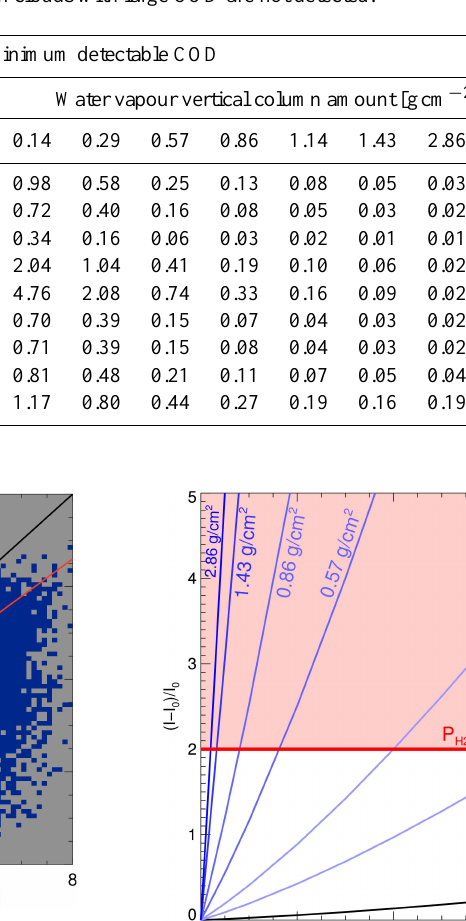
Fig. 3. Comparison of seven years (2003–2009) of SCIAMACHY WFM-DOAS and ECMWF water vapour vertical column amount (VCA). The SCIAMACHY WFM-DOAS water vapour VCA is computed from the water vapour column retrieved in the CO 2 fitting window (1558–1594nm) as a by-product of the WFM-DOAS CO 2 column retrieval. The red line shows a linear fit. Also shown in the top left inlet: the mean difference to ECMWF water vapour VCA ( d ), the standard deviation of the differences ( s ) and the correlation coefficient ( r ).